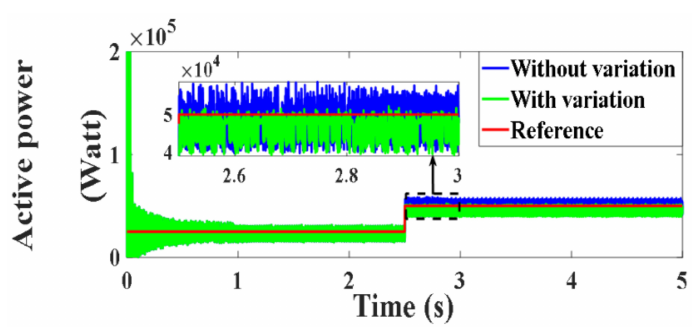
Figure 181. Active power under PVC (Watt).